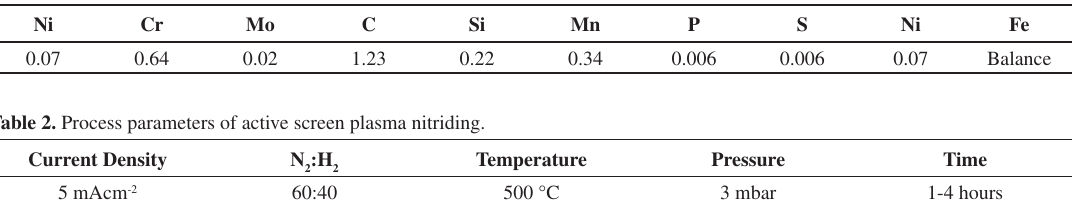
Table 1. Chemical compositions (wt. %) of high carbon